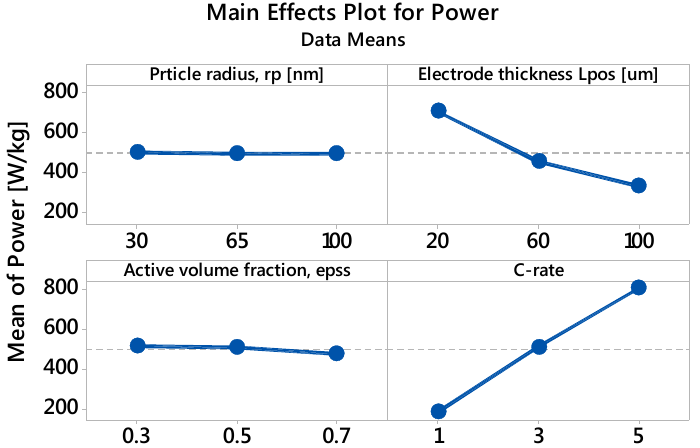
Figure 6. Main effect plot for the specific power, as a function of particle size ( r p ), electrode thickness ( L pos ), volume fraction of the active material ( ε s , pos ), C-rate, at different levels. The same kind of combined influence as for energy, is shown for the specific power (see Figure